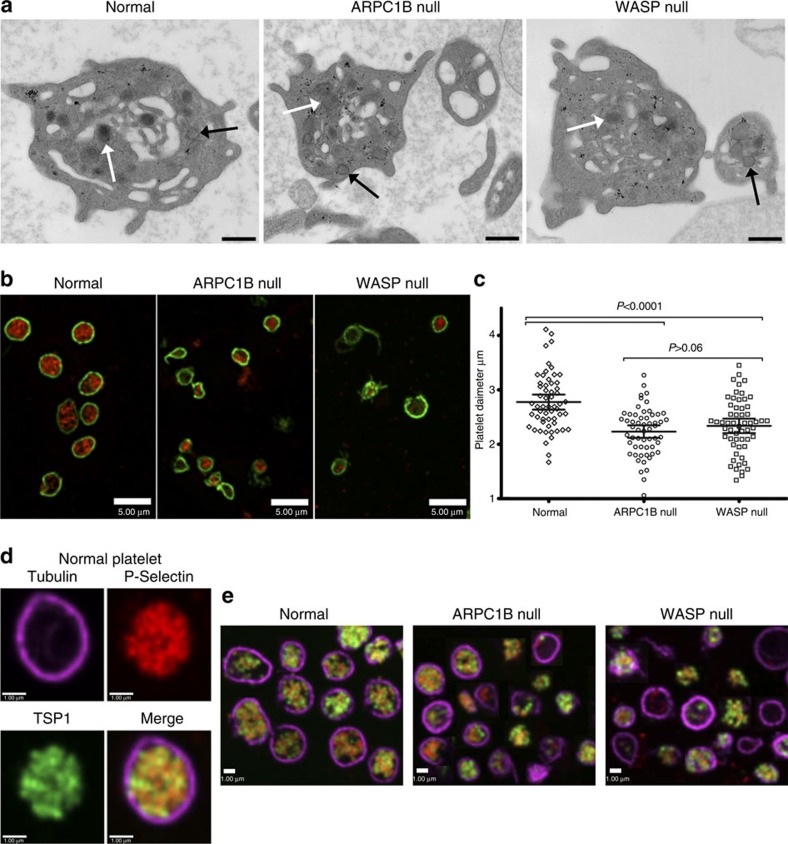
ARPC1B-null and Wiskott–Aldrich syndrome platelets are similar.(a) Transmission electron microscopy (TEM) imaging of sections from normal donor, ARPC1B-null (Patient 1) and WASP-null patient platelets show typical structures including α-granules (white arrows), mitochondria (black arrows) and internal membrane systems (bars=500 nm; see Fig. 4 for further comparisons). (b) Immunofluorescence microscopy of cells stained for circumferential ring tubulin (green) and α-granule membrane P-selectin (red) shows that ARPC1B-null and WASP-null platelets appear small and dysmorphic compared to normal (bars=5 μm). (c) A comparison of circumferential ring diameter distributions confirmed that both ARPC1B-null and WASP-null platelets are significantly smaller than normal (P<0.0001, unpaired t-test; n=57 cells; 95% confidence intervals shown) and do not differ significantly from each other. Equivalent comparisons of all patients with WASP-null and normal control platelets is shown in Fig. 5a. (d) The morphology of a normal platelet showing the typical subcellular locations of tubulin (magenta), P-selectin (red) and α-granule cargo thrombospondin-1 (TSP1, green; bars=1 μm). (e) Collections of representative cells illustrate the range of abnormal features observed in ARPC1B-null and WASP-null platelets, including small size and the variable absence of internal contents (bars=1 μm).